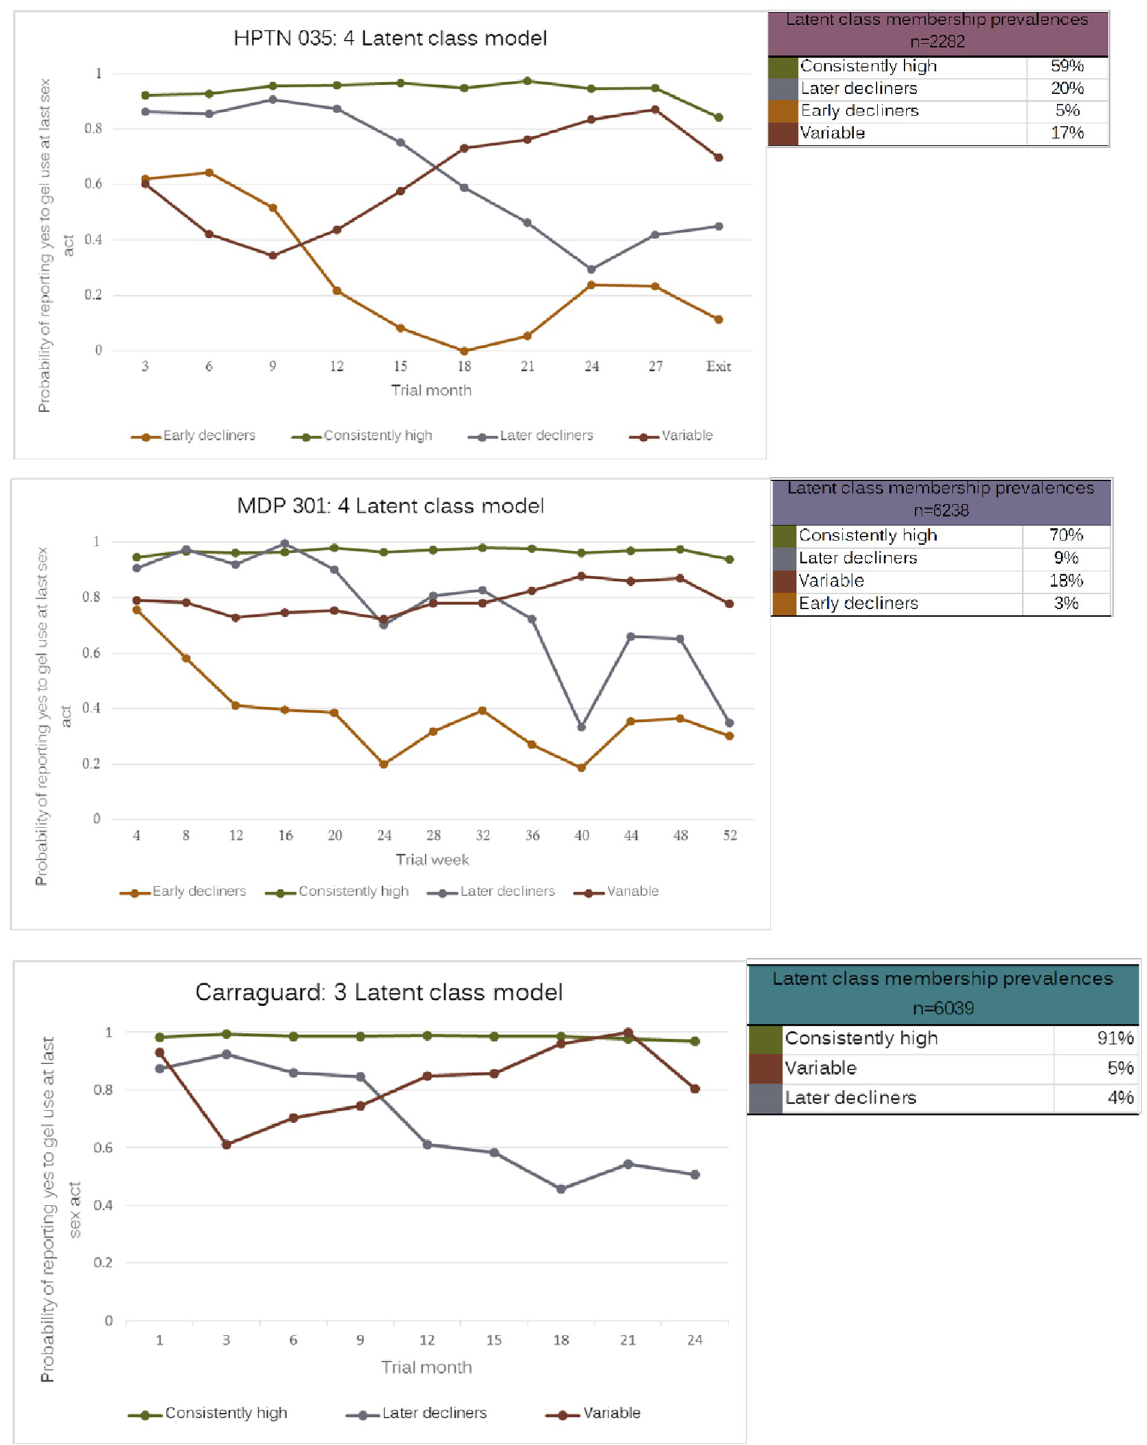
Fig 1. Latent class analysis models for 3 trials. Percentages may not total to 100 due to rounding error.